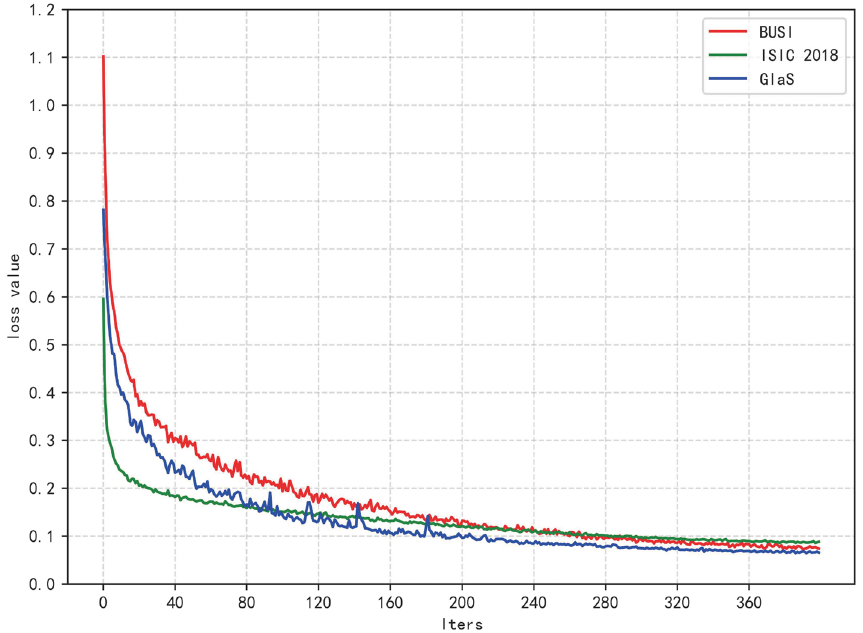
Figure 4. Training loss variation curves for different